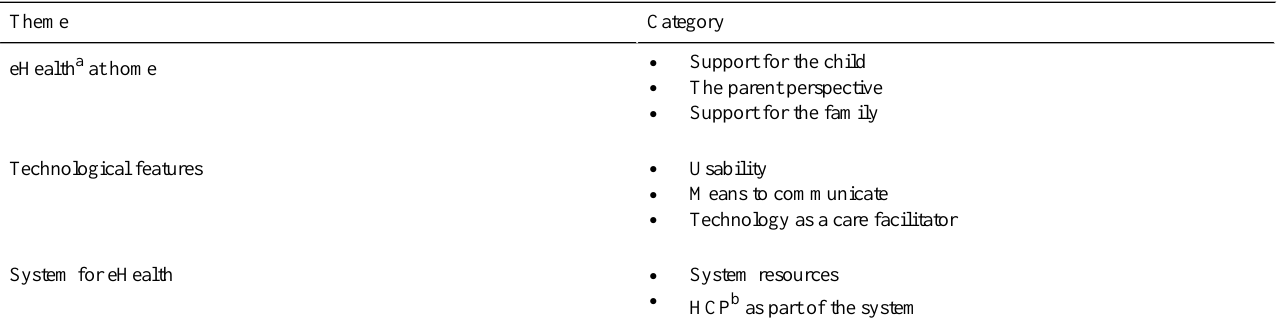
Table 4. Themes and categories developed in the thematic qualitative